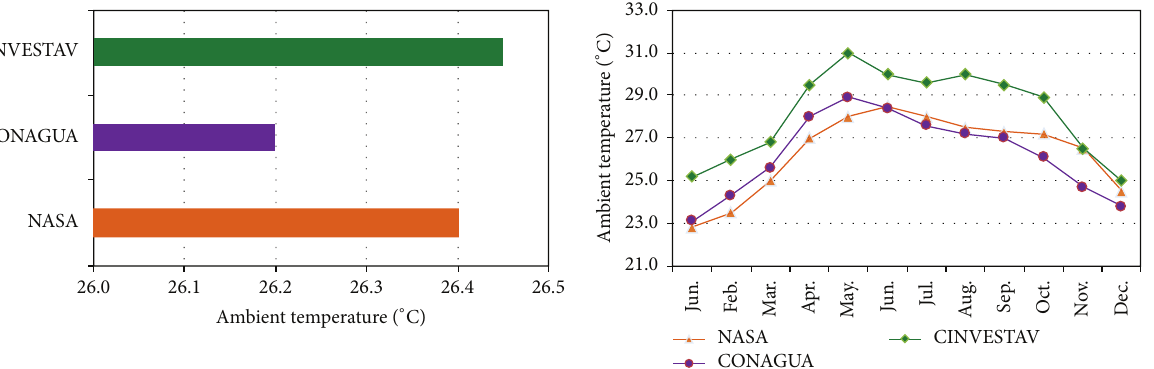
Figure 2: Temperature annual and monthly daily mean.